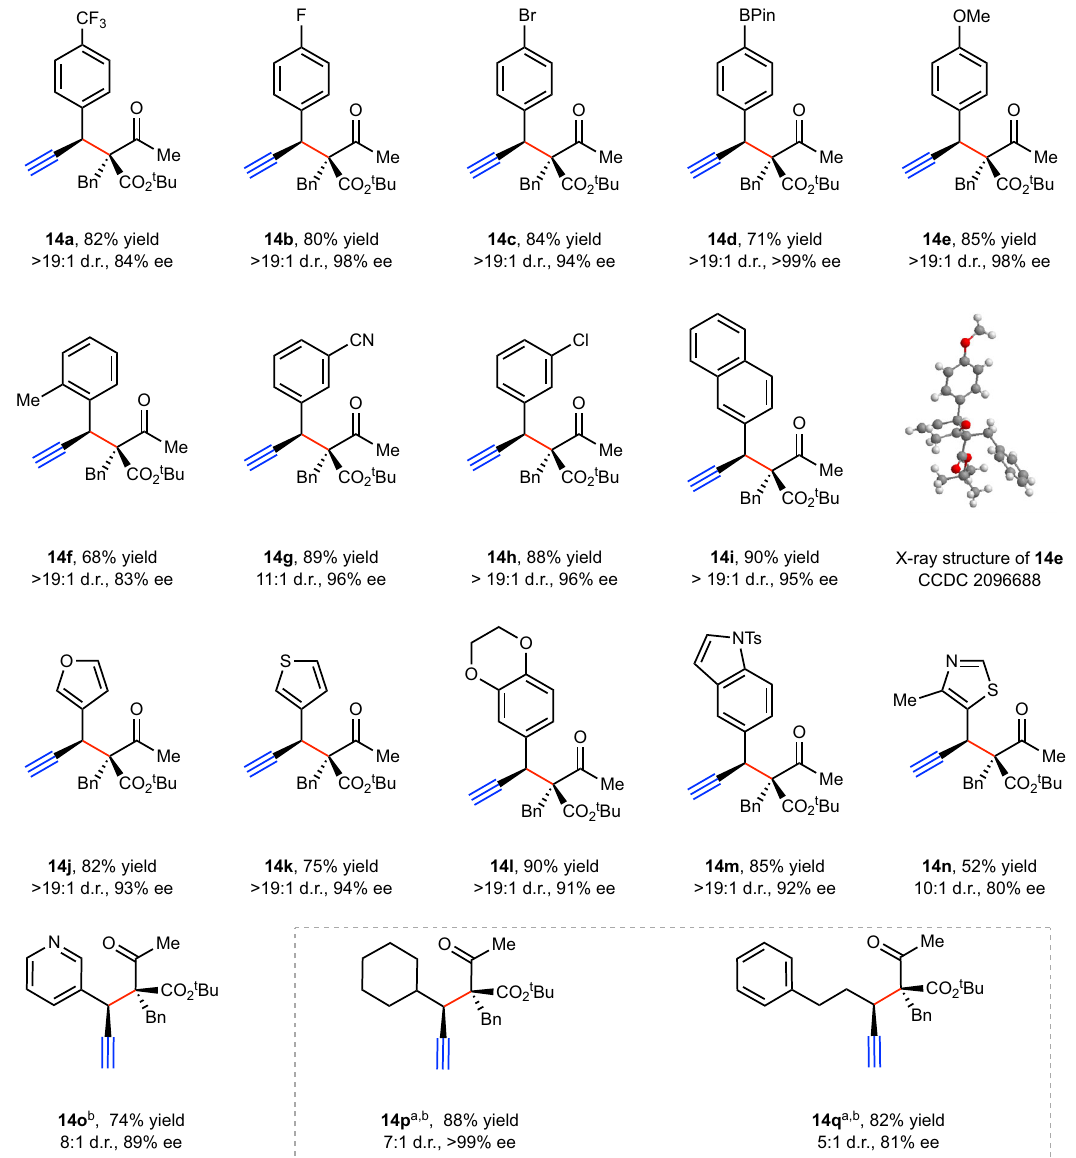
Fig. 3 Substrate scope with respect to electrophiles. Reactions were performed on a 0.2 mmol scale in THF (2 mL) with 5 mol% Cu(I), 10 mol% L5 , and 20 mol% Mg(O t Bu) 2 . Yield is that of an isolated product. The ee values were determined by HPLC analysis, the d.r. values were determined by 1 H NMR analysis of the crude reaction mixture. a The penta fl uorobenzoate group was used as leaving group. b Cu(CH 3 CN) 4 BF 4 (20 mol%), L5 (40 mol%), and Mg(O t Bu) 2 (80 mol%) were used. See SI for experimental